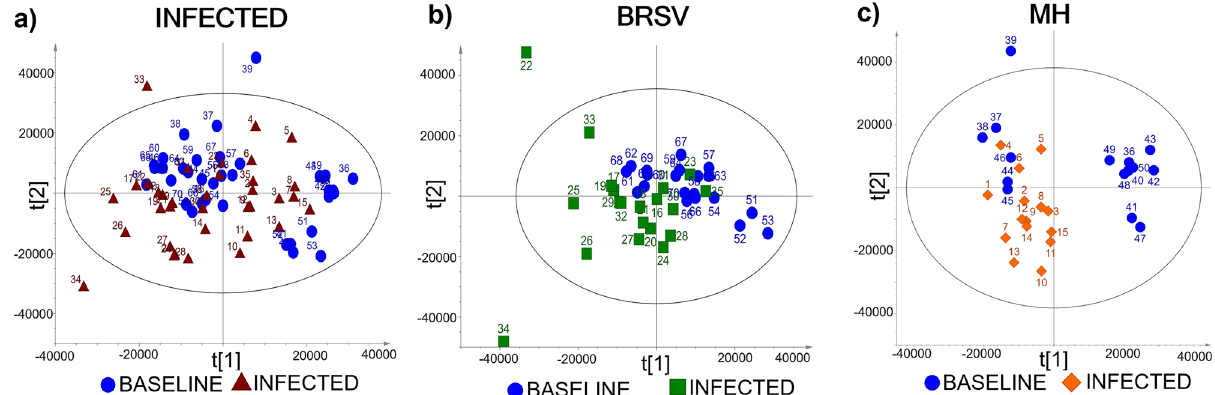
Figure 5. Principal component analysis (PCA) scores plots for 1 H-NMR spectra from Baseline and Infected plasma samples. ( a ) PCA scores plot (n = 70) from the combined V + B infection database (PC-2: R 2 X = 0.34, Q 2 = 0.26). ( b ) PCA scores plot (n = 40) from the BRSV challenge (PC-2: R 2 X = 0.34, Q 2 = 0.10). ( c ) PCA scores plot (n = 30) from the M. haemolytica (MH) challenge (PC-2: R 2 X = 0.45, Q 2 = 0.25). Labels above the scores indicate the sample ID (Table